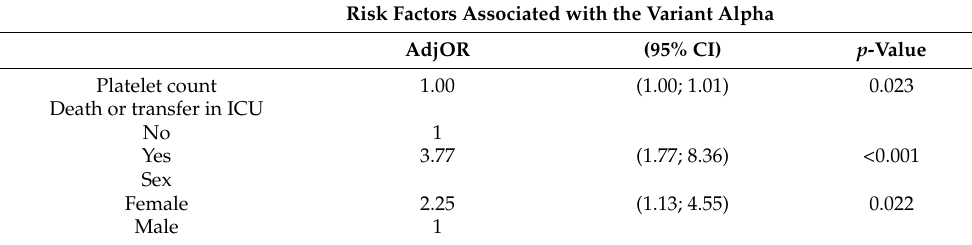
Table 3. Risk factors associated with the variant alpha.